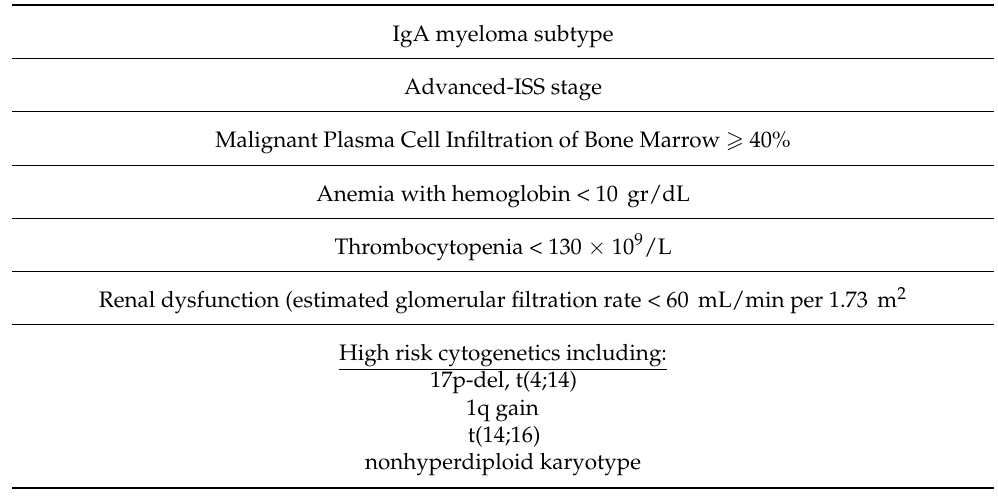
Table 2. Disease Characteristics Associated with Increased Incidence of